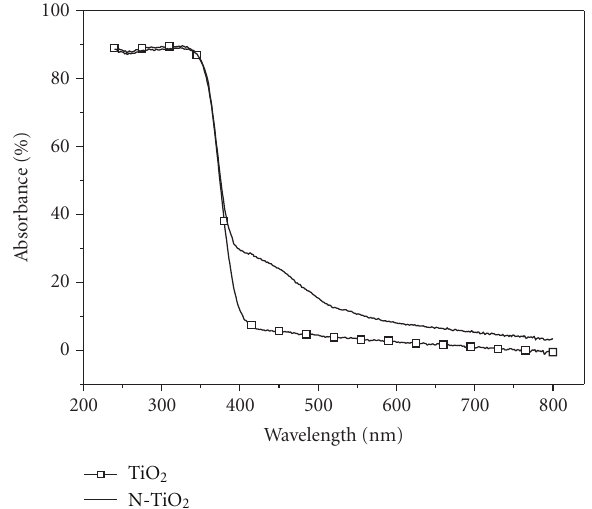
Figure 3: UV-vis absorbance spectra of commercial TiO 2 and N-doped TiO 2 samples.